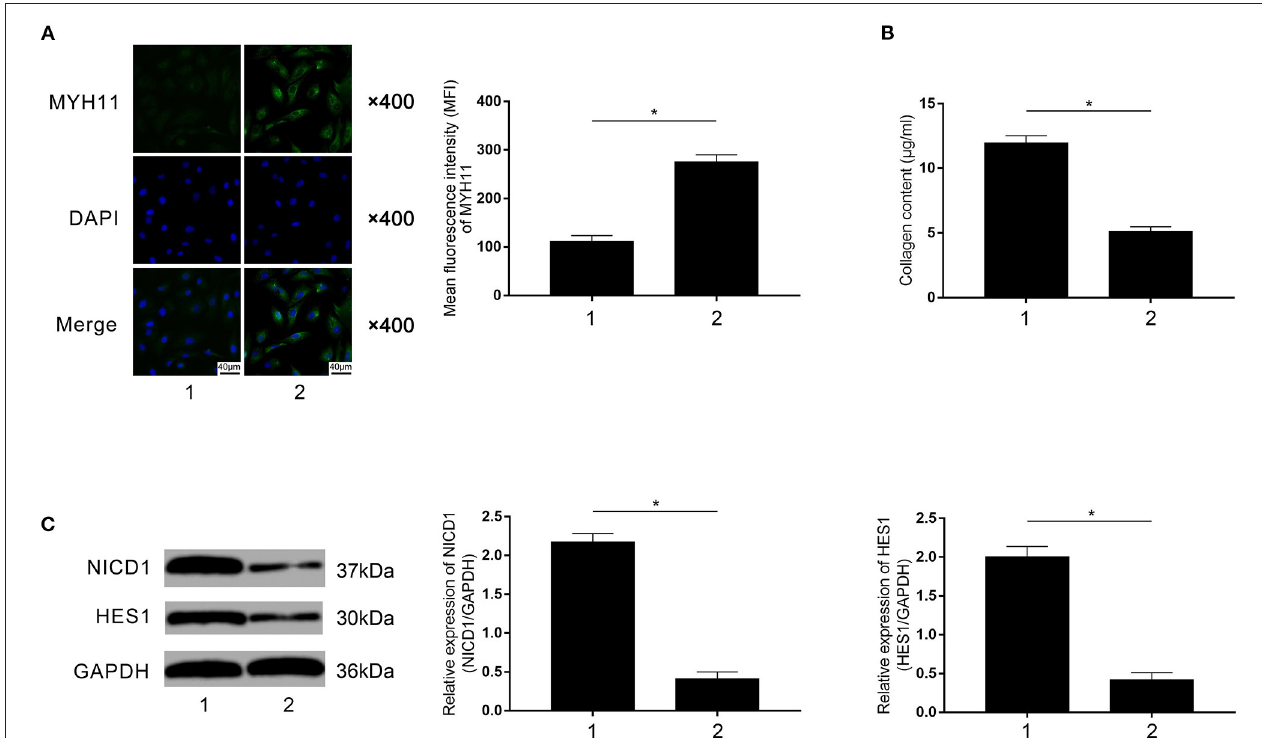
FIGURE 7 | (A) Immunofluorescence stains of MYH11, DAPI, and their merged images are demonstrated. Columns indicate the mean fluorescence intensity of MYH11 in VSMCs co-cultured with rivaroxaban-treated or un-treated macrophages exposed to FXa in the contact co-culturing model. (B) Columns indicate the measured collagen content of VSMCs co-cultured with rivaroxaban-treated or un-treated macrophages exposed to FXa in the contact co-culturing model. (C) Immunoblots of NICD1, HES1, and GAPDH are demonstrated. Columns indicate the relative expression levels of NICD1 and HES1 in VSMCs co-cultured with rivaroxaban-treated or un-treated macrophages exposed to FXa in the contact co-culturing model (data were presented as mean ± SD, n = 6, Student’s t -test and ANOVA, * P <